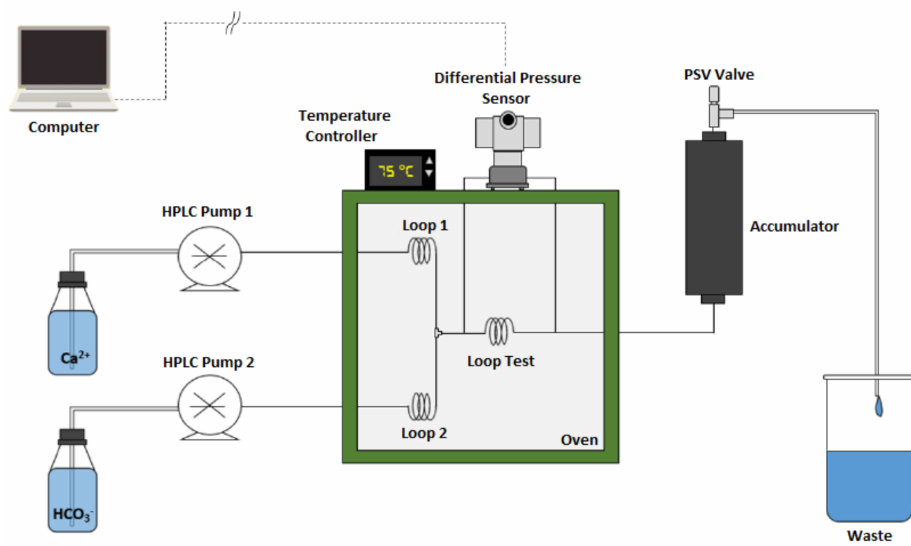
Figure 1. Scheme of the Dynamic Scale Loop (DSL) system used in the